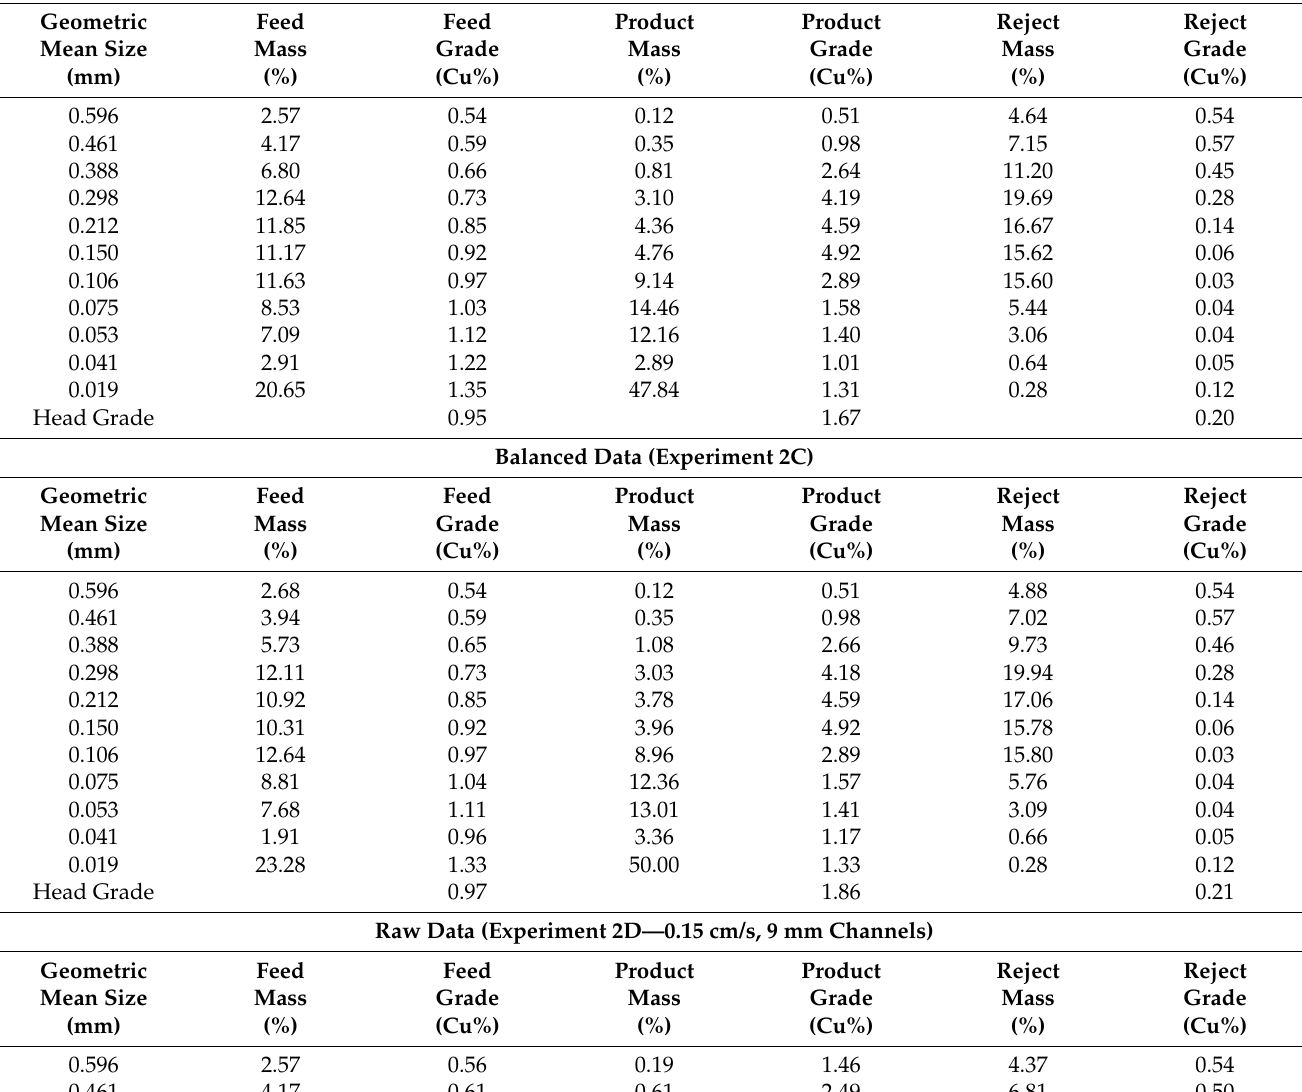
Table A1. Comparison of raw and mass balanced data for the best and poorer performing sets of experimental conditions. Consistency of the feed composition throughout the experiments de- livered strong closure in the material balance, with a requirement of only minor adjustment to experimental